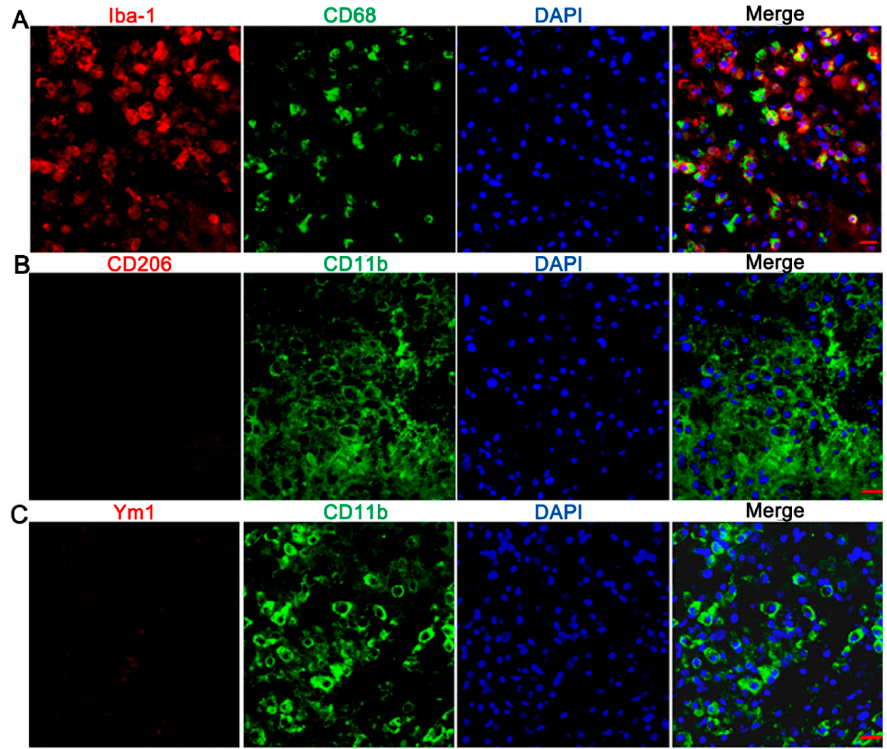
Figure 3. Ameboid microglia/macrophages were mainly differentiation (CD)68 positive in the hemorrhagic center. Brain slices (20 μ m) were taken from ICH rats at three days after collagenase VII injection. By double-label immunofluorescence staining, ameboid Iba1 positive (red, A ) or CD11b positive (green, B , C ) microglia/macrophages in the hemorrhagic center were CD68 positive (green, A , n = 3), neither CD206 nor chitinase 3-like 3 (Ym1) positive (red, B , C ) ( B and C , n = 3). Bar = 30 μ m.